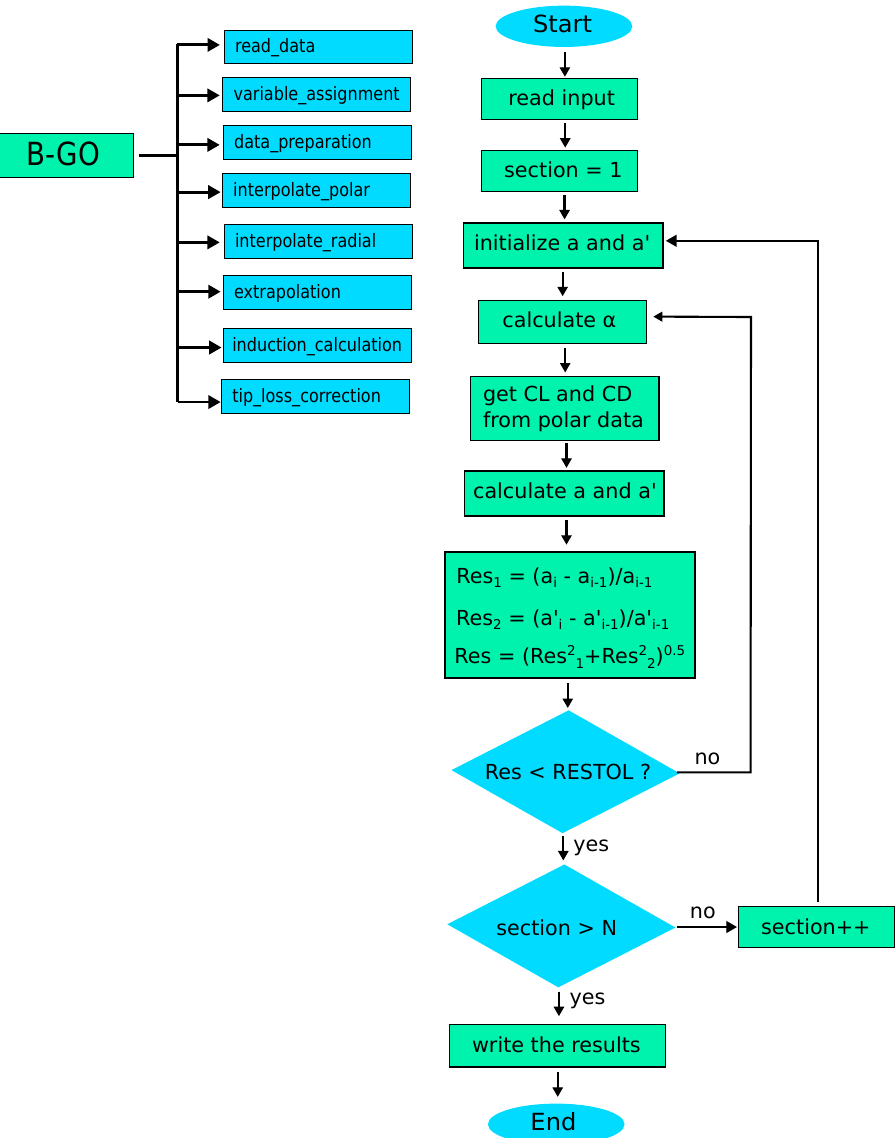
Figure 3. List of subroutines constructing the BEM code and the calculation